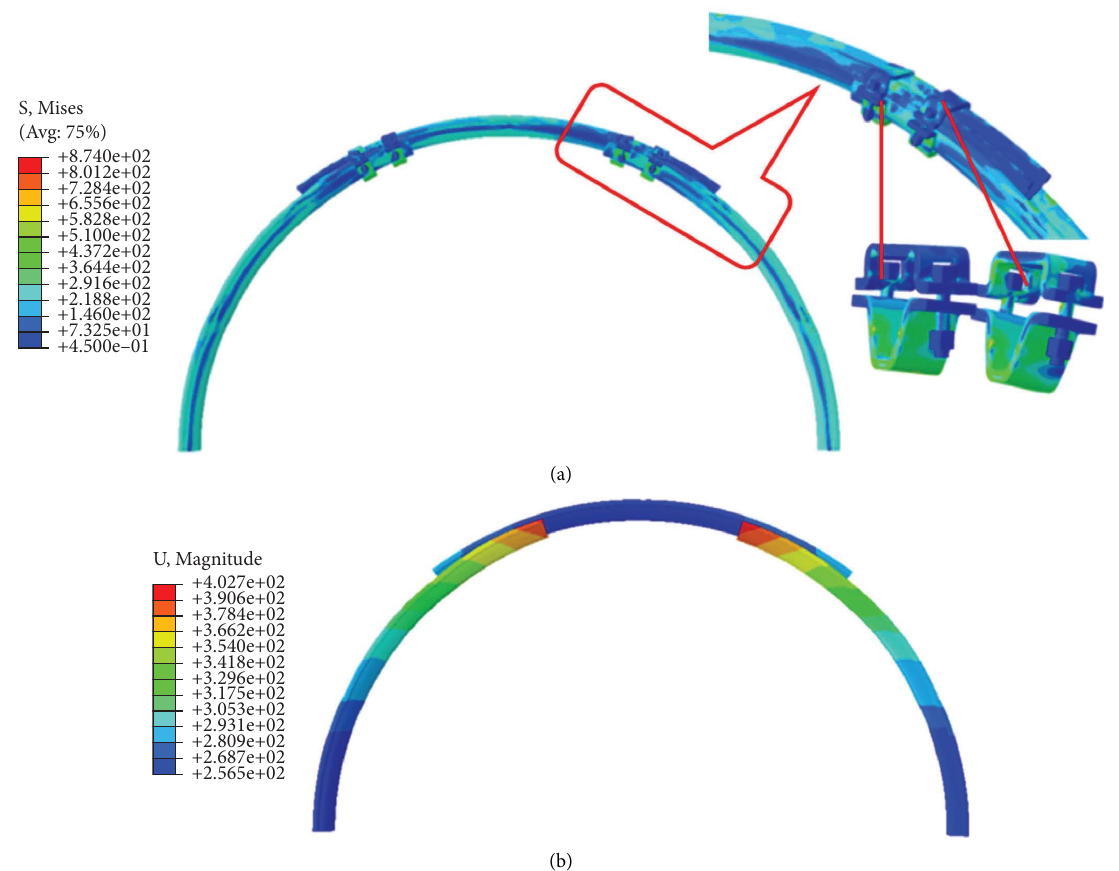
Figure 12: Stress and displacement nephogram of the stent ( t � 0.028s). (a) Support stress and deformation diagram. (b) Support the displacement and deformation